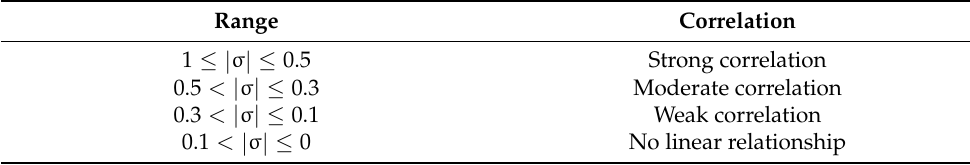
Table 2. Correlation grading table of Spearman’s